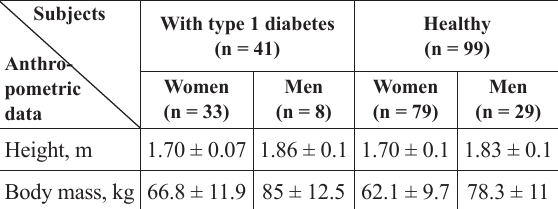
Table . Anthropometric data of healthy subjects and subjects with type 1